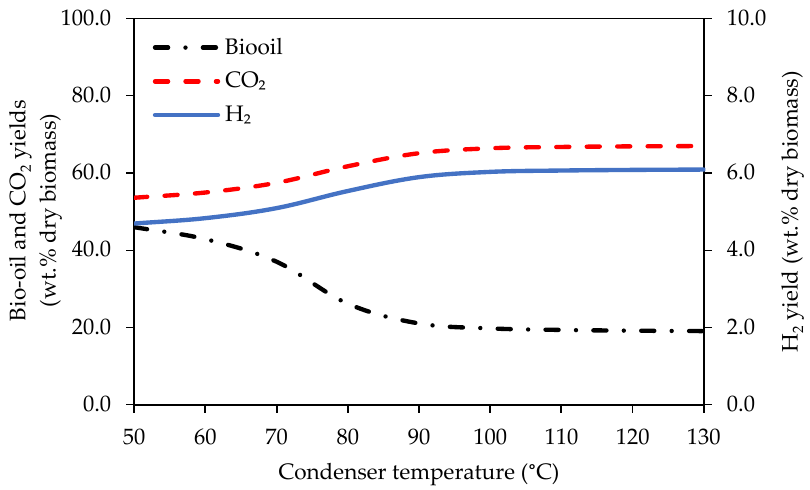
Figure 8. The yield of bio-oil, H 2 , and CO 2 obtained from Scheme 2 production system at different bio-oil condenser temperatures.